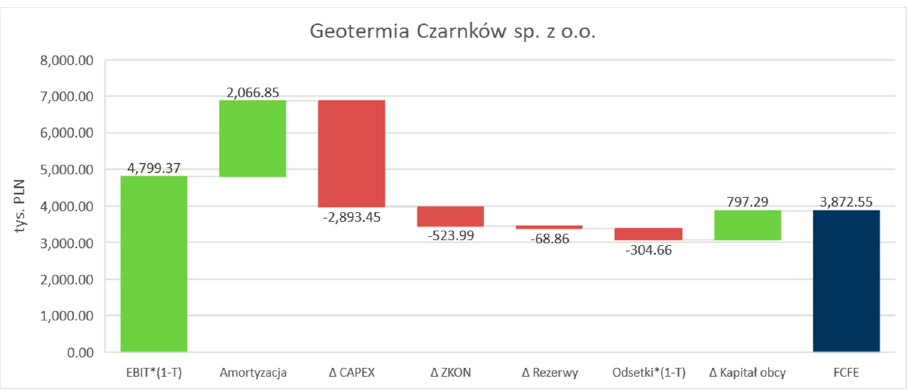
Figure 13. FCFF cash flows generated by Geotermia Pyrzyce Sp. z o.o. in 2016–2019. Source: Own study on the basis of: [54].